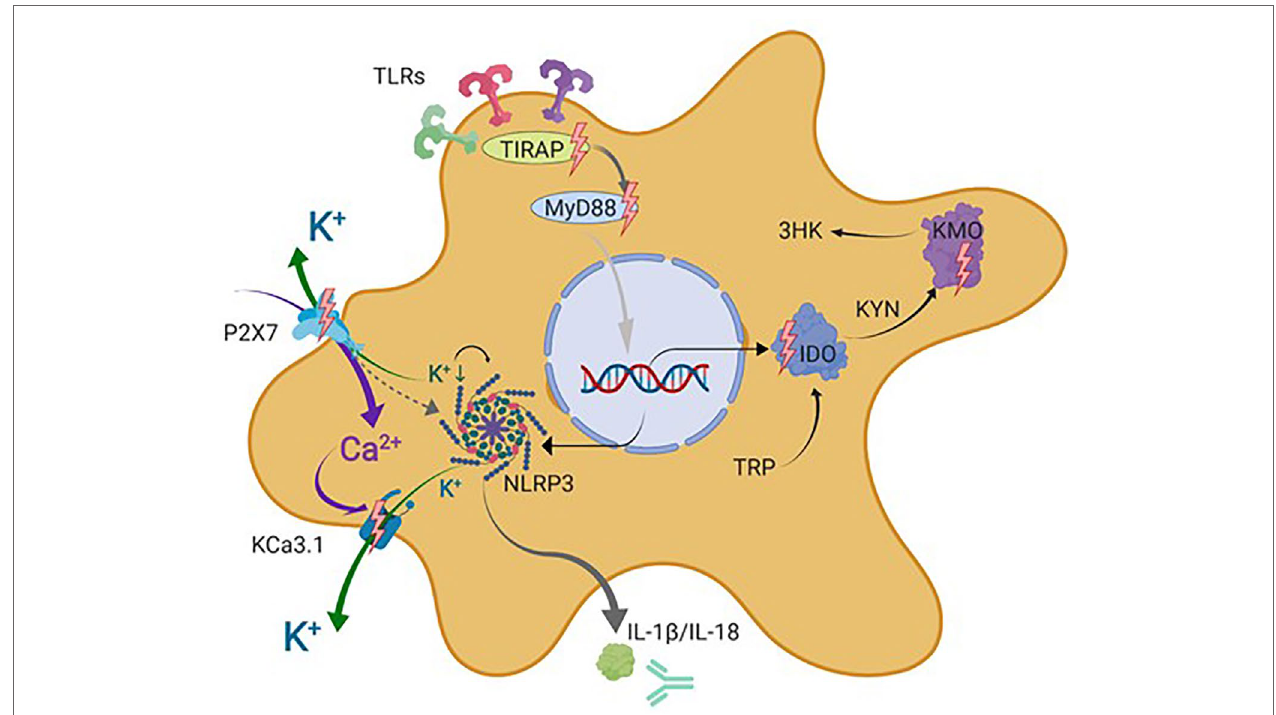
FIGURE 4 | Schematic representation of microglial drug targets discussed in this review. This simplified schematic does not contain all signal transduction molecules known to be involved in the described signaling cascades but focuses on the microglial drug targets discussed in this review indicated by lighting bolts and antibody symbol. IDO, indolamine-2,3-dioxygenase; IL-1 β, interleukin 1 beta; IL-18, interleukin 18; K Ca 3.1, intermediate-conductance calcium-activated potassium channel 3.1; KYN, kynurenine; AA, anthranilic acid; 3-HK, 3-hydroxykynurenine; KATs, kynurenine aminotransferases; KMO, kynurenine 3-monooxygenase (kynurenine 3-hydroxylase); NLRP3, nucleotide-binding oligomerization domain, leucine-rich repeat, and pyrin domain–containing inflammasome complex 3; P2X7, ionotropic P2 receptor 7; TIRAP, TIR domain–containing adaptor protein; MyD88, myeloid differentiation primary response protein 88; TDO, tryptophan-2,3-dioxygenase; TRP, tryptophan. Figure created with